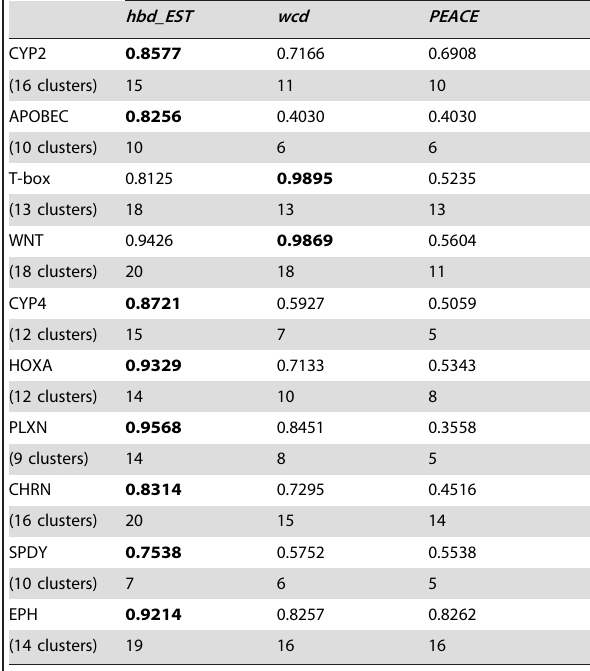
Table 4. The comparative evaluation of our proposed hybrid distance measure ( hbd_EST ), with the wcd and PEACE clustering tools.